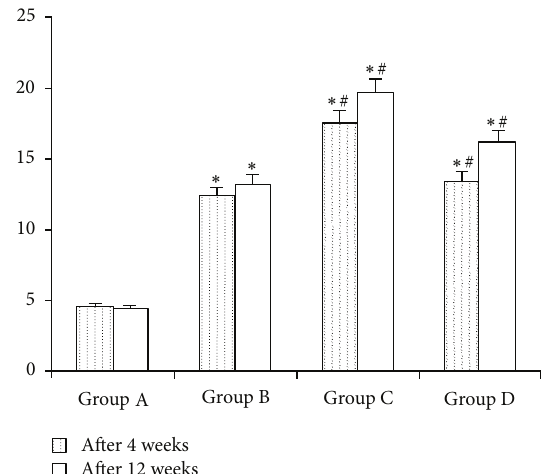
Figure 1: The different effect on FPG in each group of various periods. A: normal control group; B: diabetes model group; C: sim- vastatin intervention group; D: Simvastatin treatment group. ∗ 𝑃 < 0.05 compared with the control group. # 𝑃 < 0.05 compared with the untreated diabetic group.